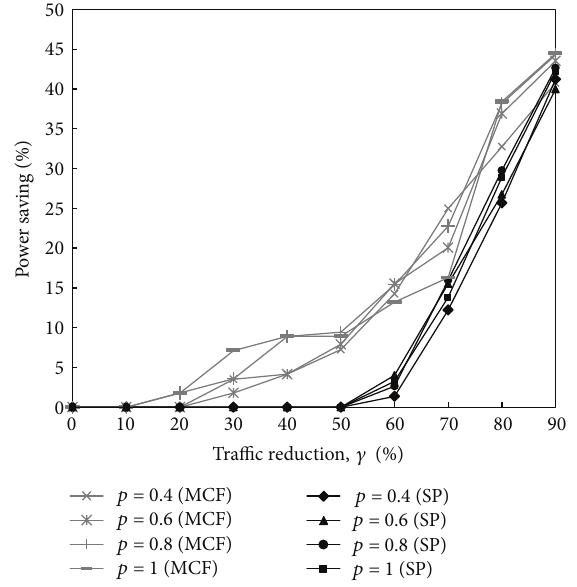
Figure 7: Percentage of power consumption saving obtained using MEE Heuristic with MCF and Dijkstra rerouting approach and in the case of the Network 6-3-4.